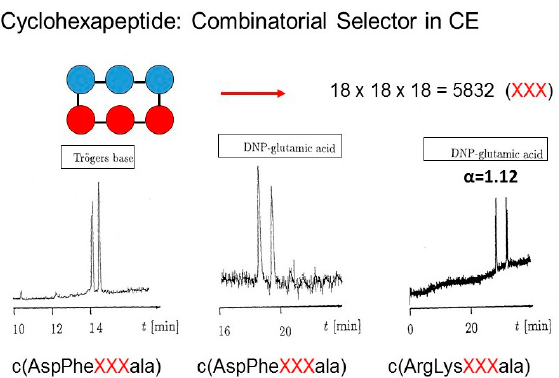
Figure 6. Enantioseparation of racemic Tröger’s base and DNP- D , L -glutamic acid with combinatorial cyclohexapeptides by CE. Conditions: 10 mmol cyclopeptide library cyclo (OOXXXO) in phosphate buffer pH 7.4 (20 mmol). Capillary: 50 cm (effective) × 50 μ m I.D., 20 kV (left, middle) and 10 kV (right), detection at 260 nm (left) and 340 nm (middle and right) [44].